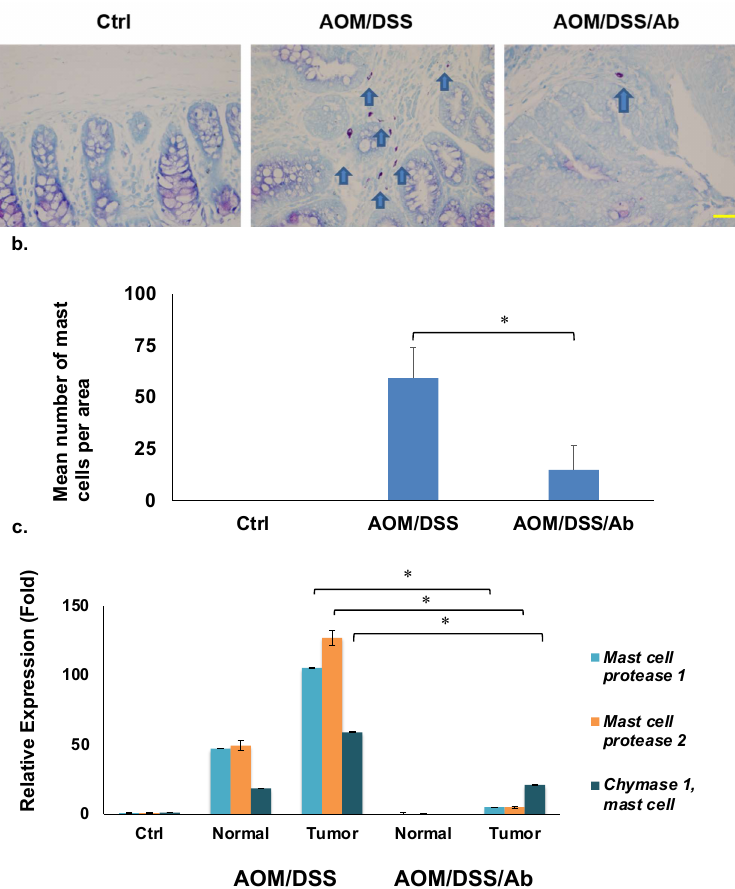
The top 10 genes downregulated in cancer tissue of AOM/DSS mice by adding TNF- α Ab are shown with gene symbols. * Ab (-)/Normal, Values were calculated by dividing relative gene expression in cancer of AOM/DSS (Ab-) by that in normal control (Normal). † Ab (-)/Ab (+), Values were calculated by dividing relative gene expression in cancer of AOM/DSS (Ab(-)) by that of AOM/DSS/Ab (Ab(+)).